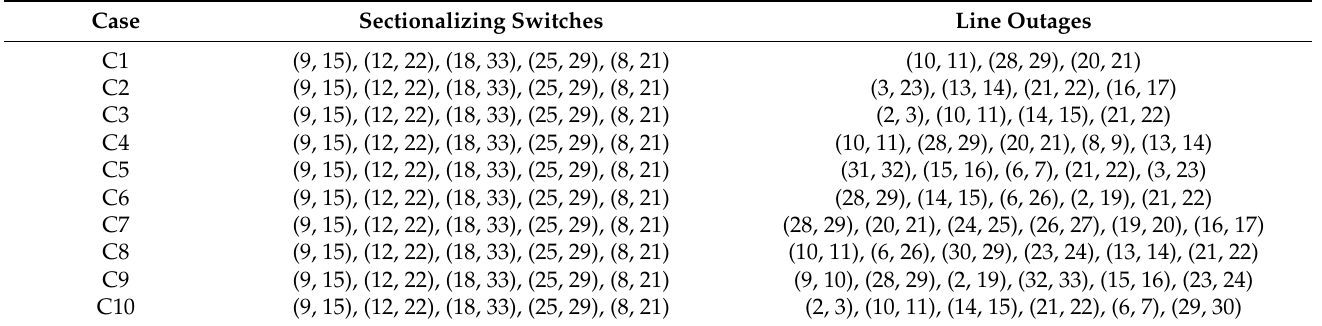
Table 1. Scenarios for the virtual distribution network.